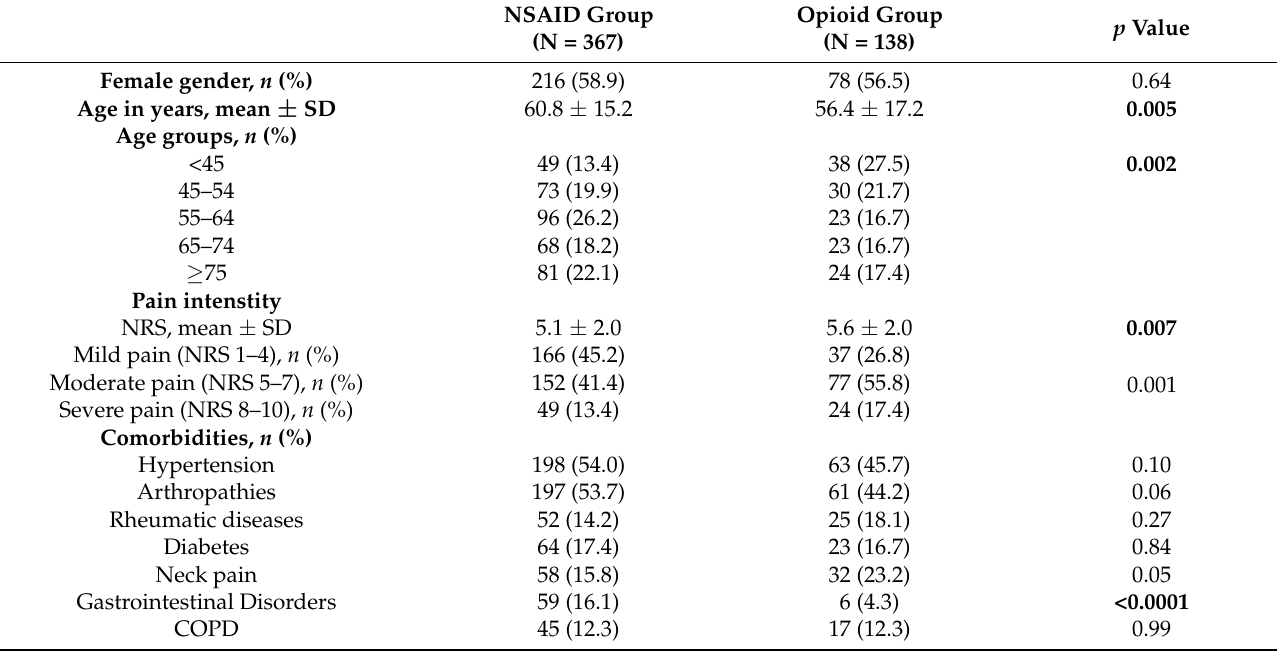
Table 1. Characteristics of patients with LBP receiving Non-Steroidal Anti-Inflammatory Drugs (NSAID group) or opioid prescriptions (opioid